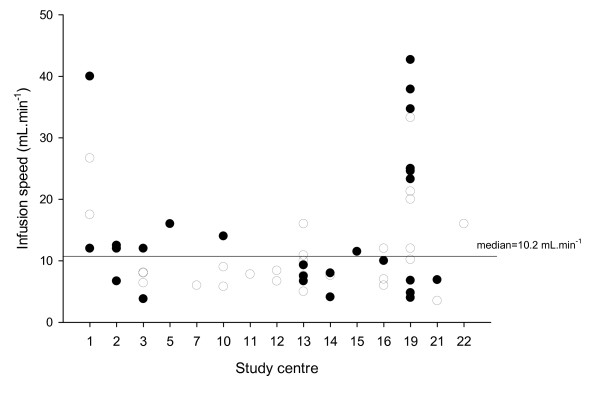
Individual patient infusion speed at each study centre. White dots refer to patients in the 25 IU/kg group and black dots refer to those in the 40 IU/kg group.